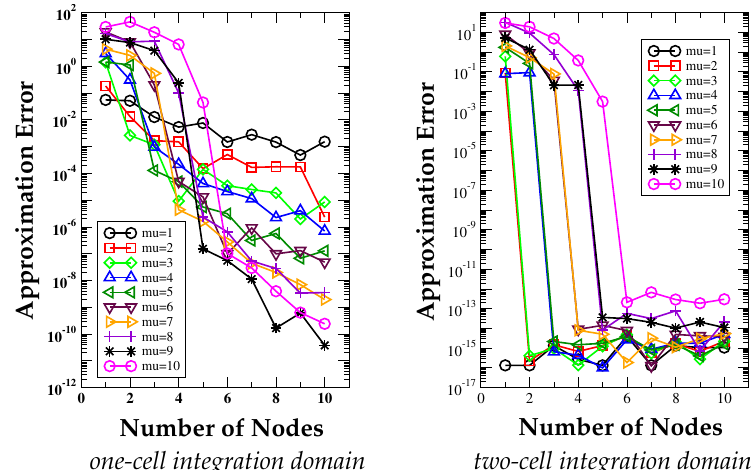
Figure 7. Test Case 6. Approximation error curves versus the number of nodes m for the numerical integration of the combination of a singular function and the Chebyshev degree-10 polynomial of the first kind on a d = 10 dimensional domain.